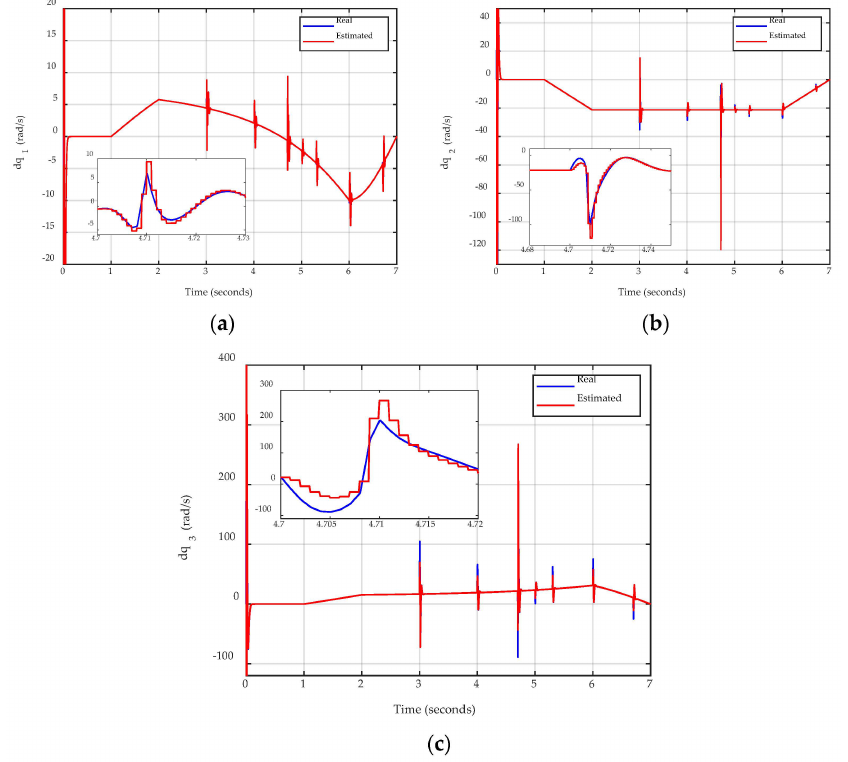
Figure 7. Velocity estimation performance of ( a ) boom, ( b ) arm, and ( c ) bucket in Case